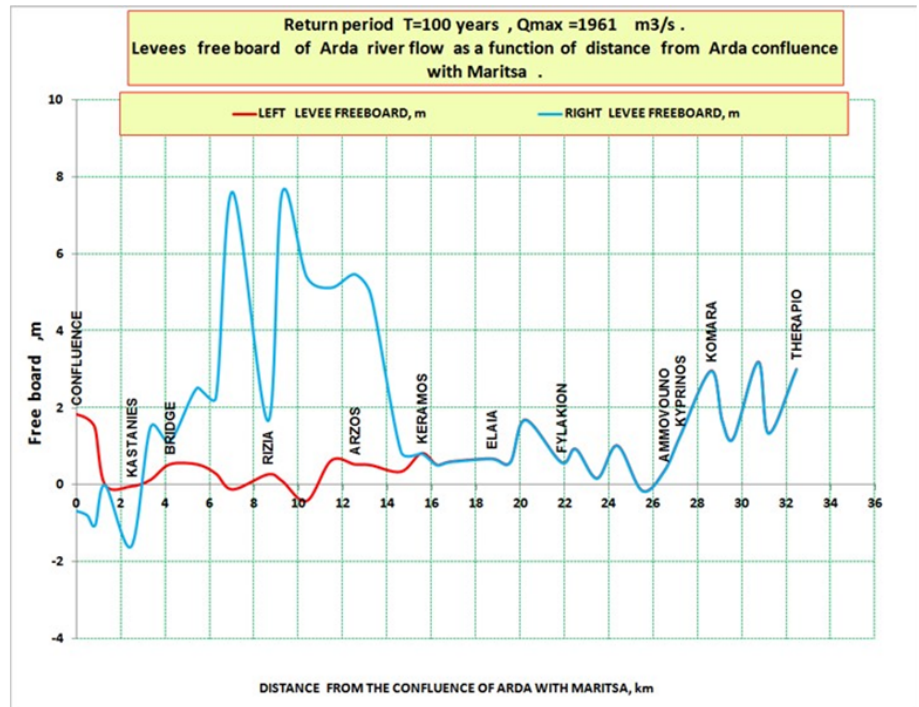
Figure 7. Free board (distance of levees to water elevation) in relation to the distance from the junction of Arda and Evros rivers. The elevations of the left and right levees are the almost same from chainage 16 km to chainage 33